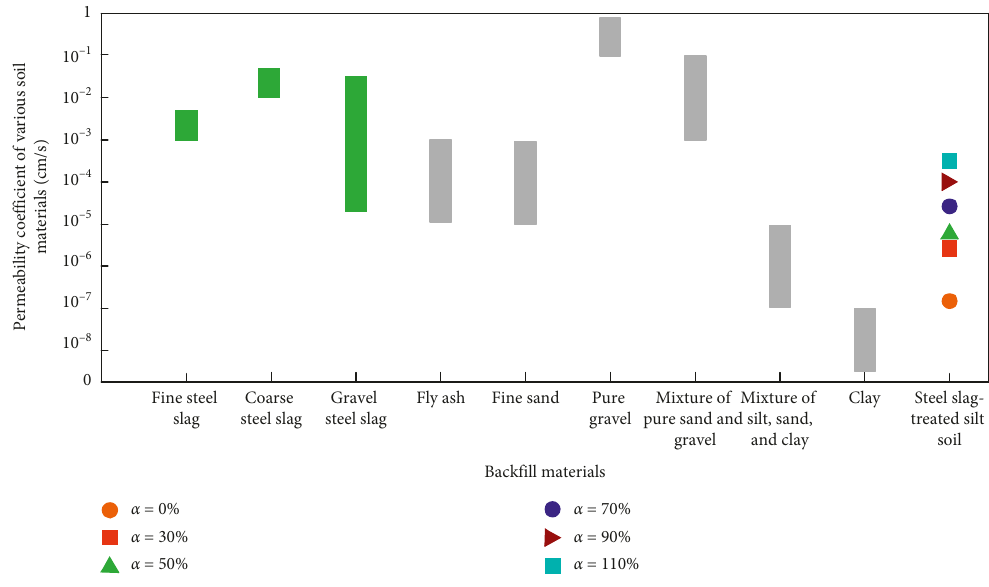
Figure 12: Comparison of permeability coefficients between steel slag, steel slag-treated silt soil, and traditional